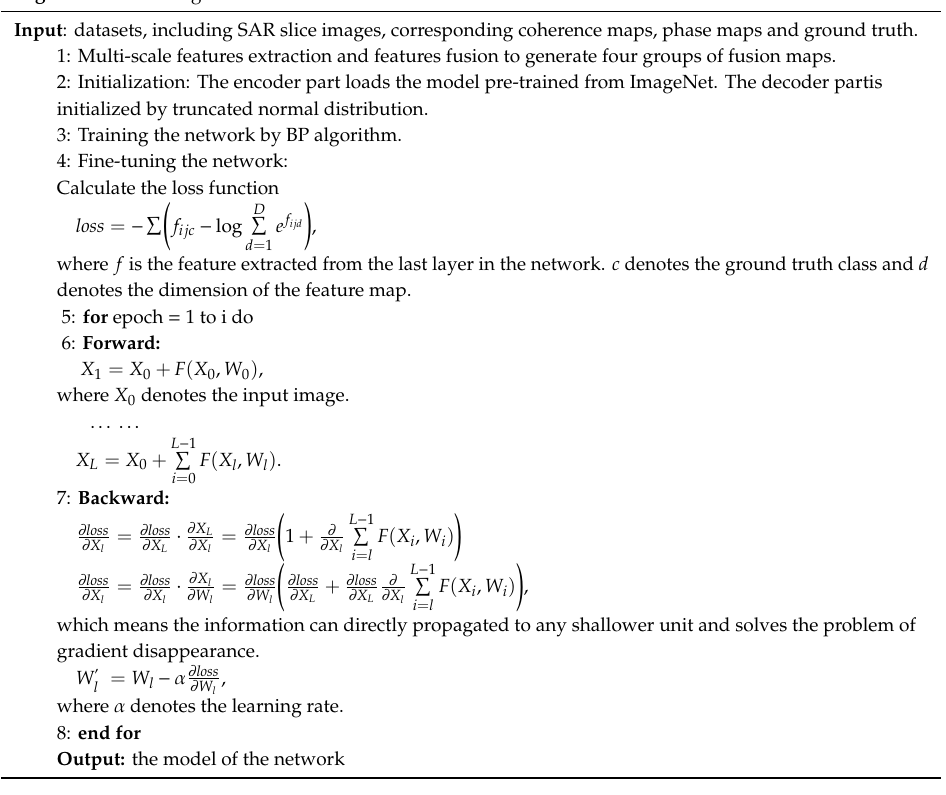
Algorithm 1: Training the whole network